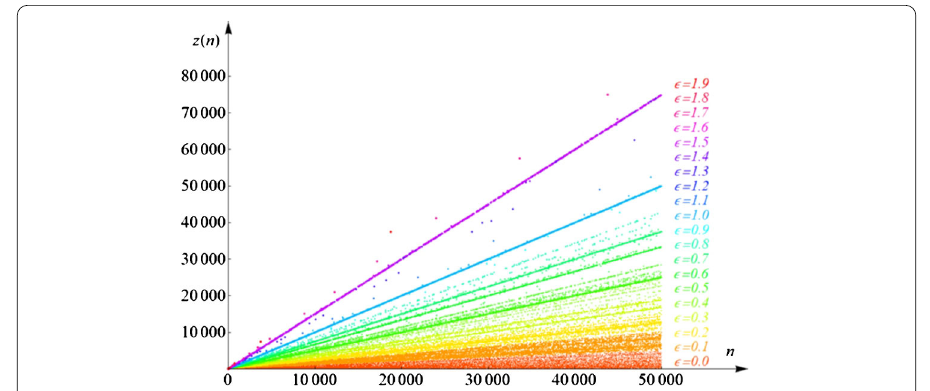
Figure 1 The scatterplot of the function z ( n ) for values of n from 1 to 50,000. The regions (cid:2) n < z ( n ) ≤ ( (cid:2) + 0.1) n , (cid:2) ∈ { 0,0.1, ... ,1.9 } are colored by the corresponding value of